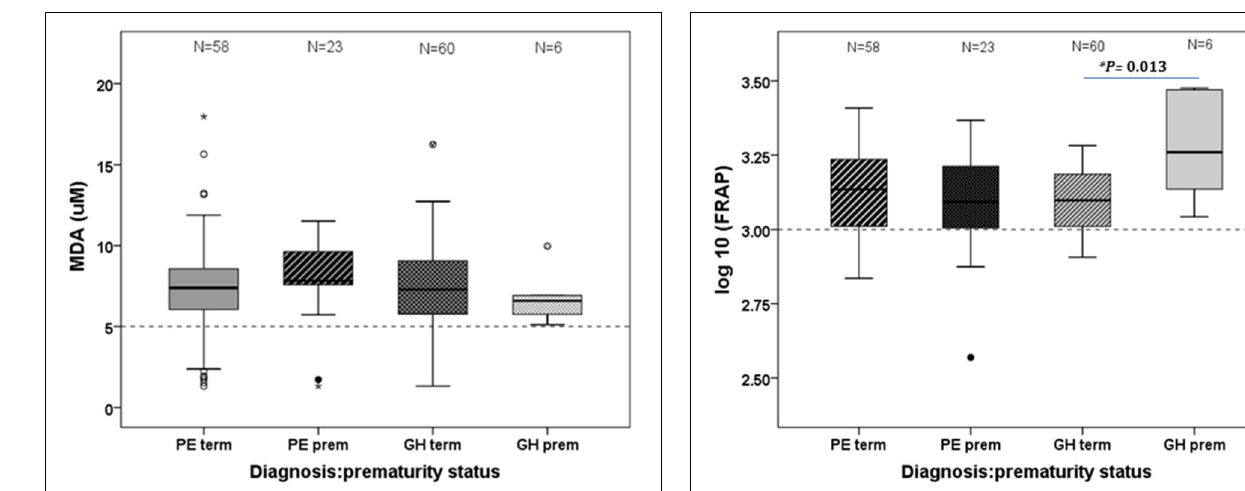
FIGURE 1 | Lipid peroxidation, measured in units of MDA, shown by prematurity status in the PE and GH diagnostic groups. No differences were observed between hypertensive diagnostic groups or between term and preterm status. The dotted line is the median reference value for non-pregnant females within this assay.